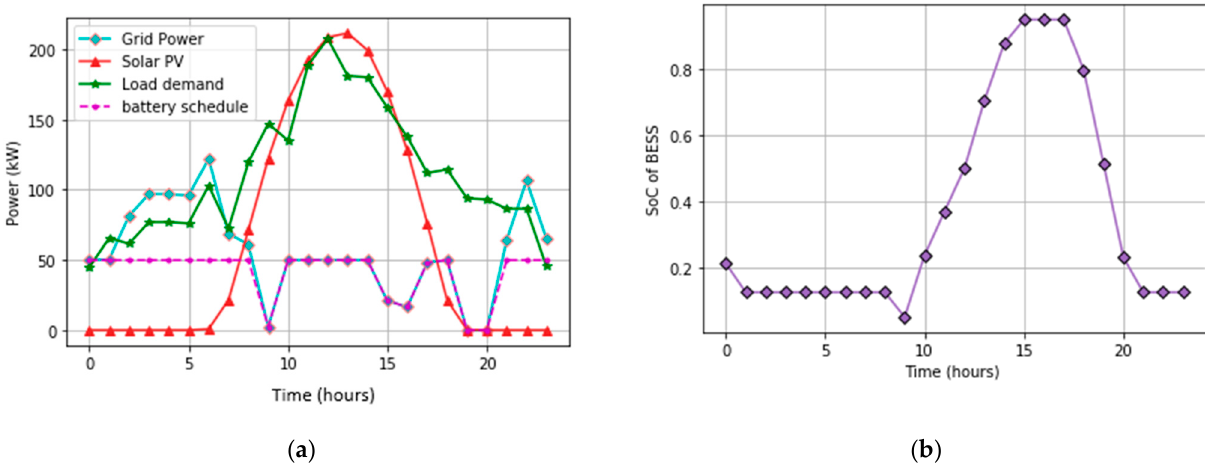
Figure 4. Observations for trading algorithm; ( a ) Optimized grid and battery schedules for 24 h horizon. ( b ) Tendency of the SoC of the BESS.